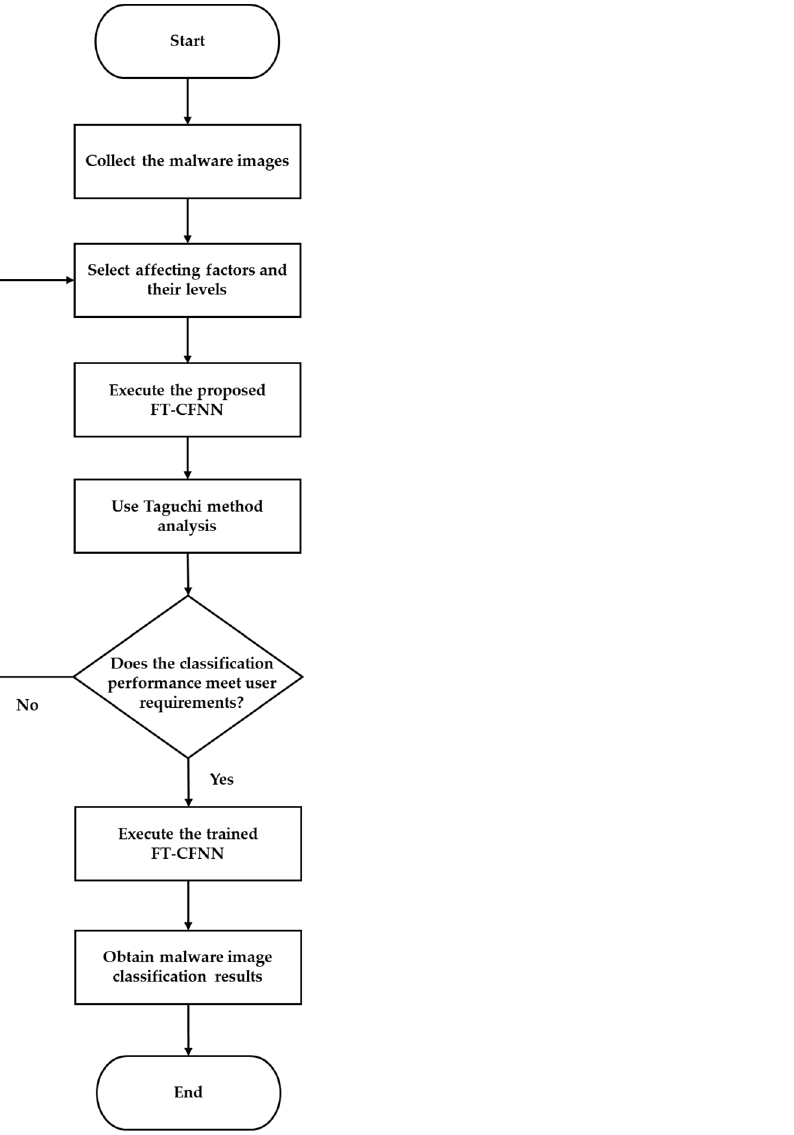
( b ) Figure 3. Feature fusion methods: ( a ) GMP fusion and GAP fusion as well as ( b ) CGMP fusion and CGAP fusion. 2.1.4. FNN Layer An FNN combines the logical reasoning of humans and the learning abilities of neu- ral networks. FNNs have been successfully used in classification systems [30,31]. Figure 4 illustrates the architecture of an FNN, which primarily contains a fuzzification layer, fuzzy rule layer, and defuzzification layer. Fuzzy rules are inferred using IF–THEN rep- resentations. These rules are expressed as follows: 𝑅𝑢𝑙𝑒 (cid:3037) ： IF 𝑥 (cid:2869) is 𝐴 (cid:2869)(cid:3037) and 𝑥 (cid:2870) is 𝐴 (cid:2870)(cid:3011) … and 𝑥 (cid:3041) is 𝐴 (cid:3041)(cid:3037) ,THEN 𝑦 (cid:3037) is 𝑤 (cid:3037) .